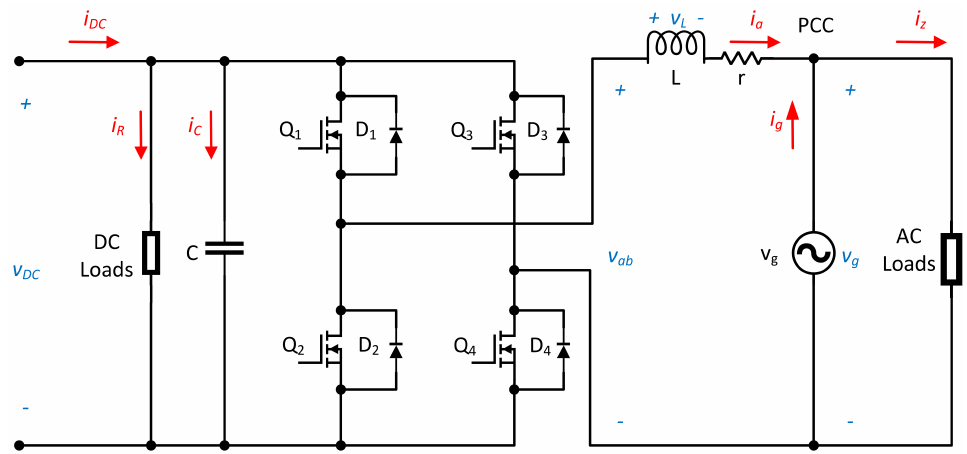
Figure 5. Single phase DC-AC full bridge